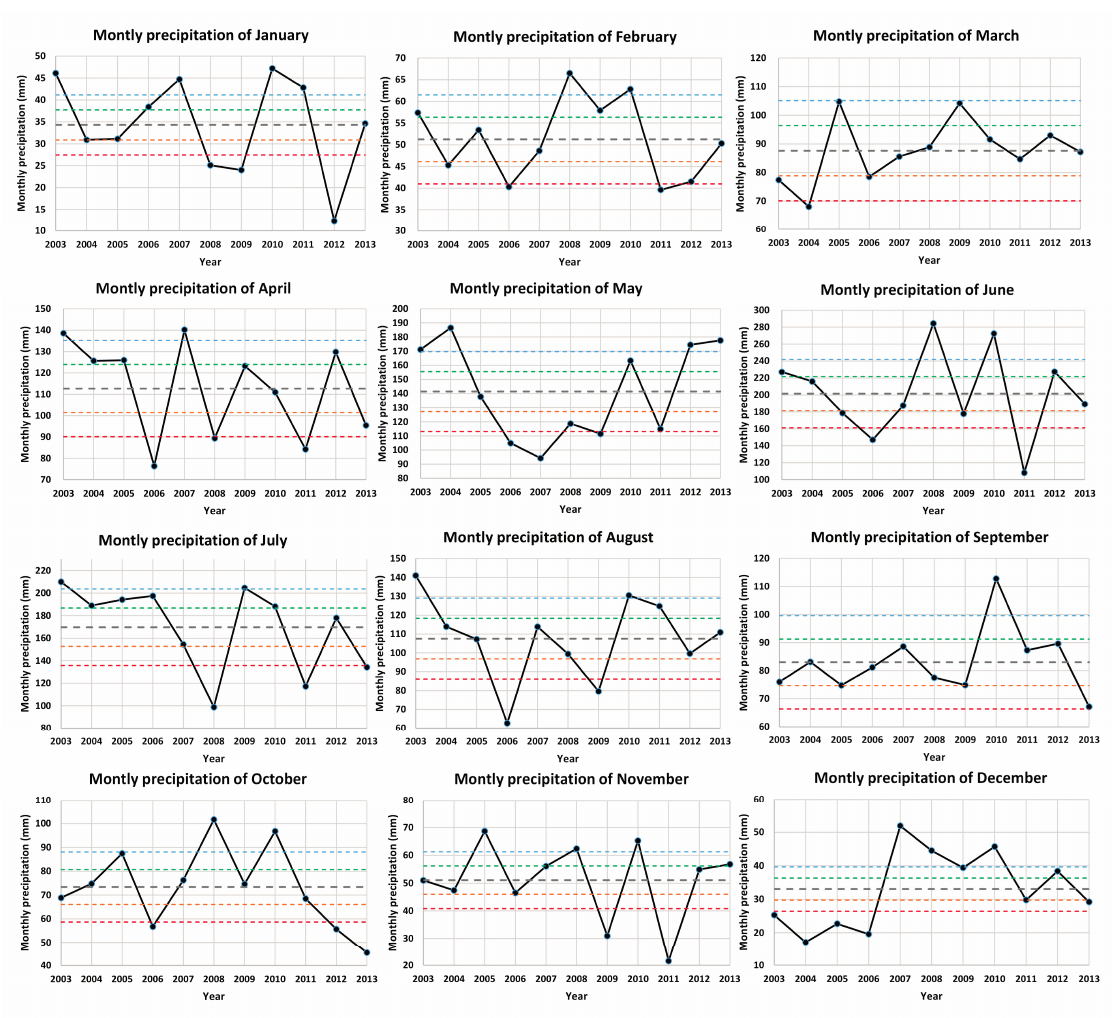
Figure 8. Monthly precipitation, the monthly mean precipitation (MMP) line, the 20%